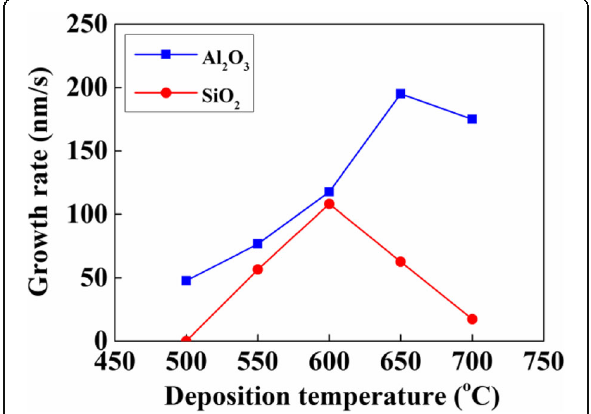
Fig. 6 The growth rate of VACNTs variation with deposition temperature on Al 2 O 3 and SiO 2 buffer